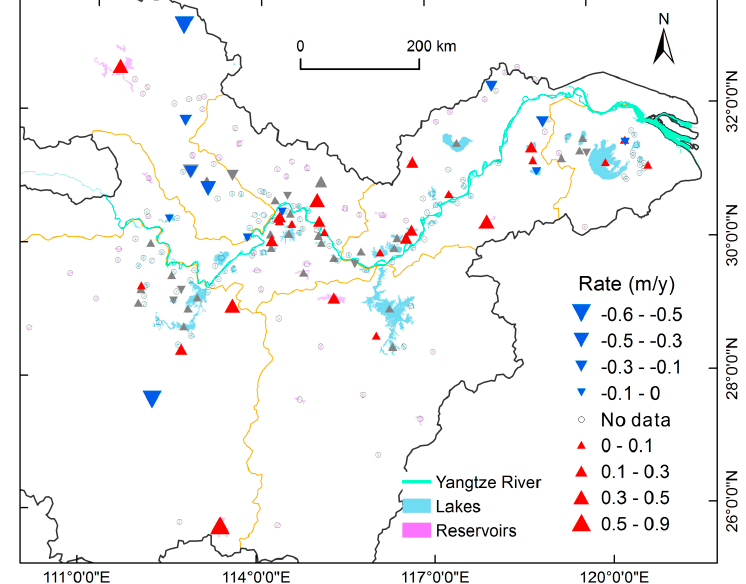
Figure 7. Spatial patterns of lake level change rates in the MLYB during 2002-2017. Note that solid red and blue triangles indicate significant changes at the 90% confidence level while grey triangles indicate no significant changes at this level.